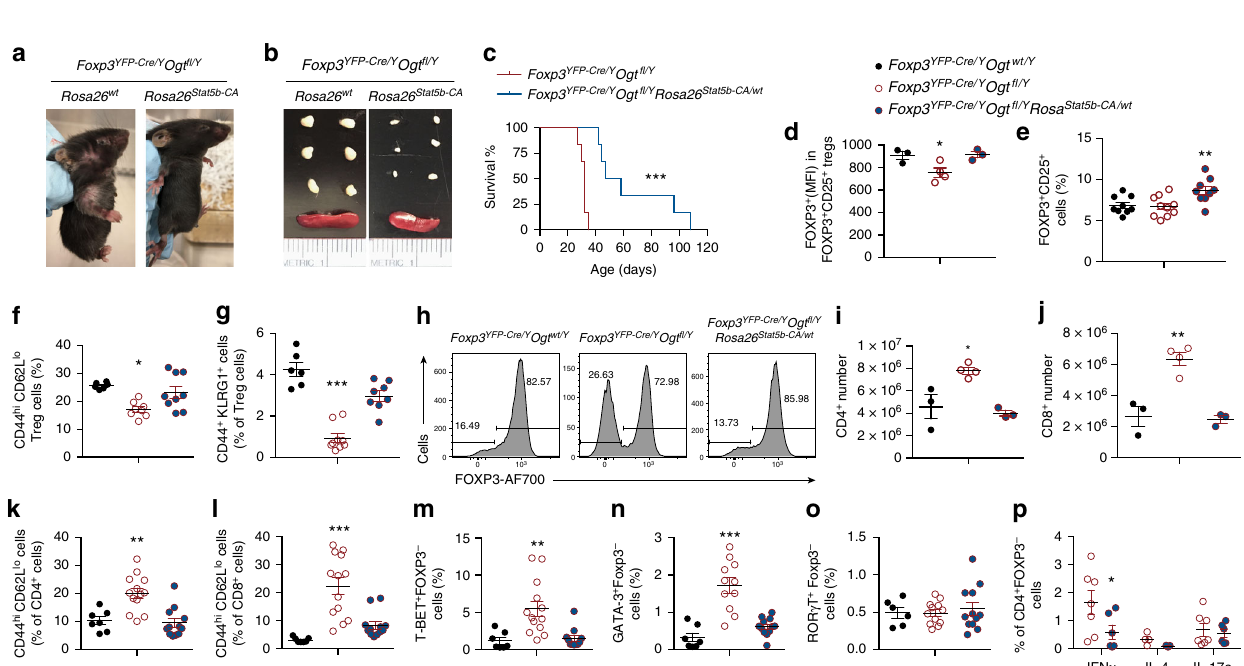
Fig. 7 Constitutive activation of STAT5 partially rescues Treg cell dysfunction. a , b Representative images of mice ( a ) and peripheral LNs and spleen ( b ) from 2-week-old Foxp3 YFP-Cre/Y Ogt fl /Y and Foxp3 YFP-Cre/Y Ogt fl /Y Rosa26 Stat5b-CA/wt mice. c Survival curve of Foxp3 YFP-Cre/Y Ogt fl /Y and Foxp3 YFP-Cre/Y Ogt fl /Y Rosa26 Stat5b-CA/wt mice ( n = 6). d MFI of FOXP3 in FOXP3 + CD25 + Treg cells in the LNs from 2-week-old Foxp3 YFP-Cre/Y Ogt wt/Y , Foxp3 YFP-Cre/Y Ogt fl /Y and Foxp3 YFP-Cre/Y Ogt fl /Y Rosa26 Stat5b-CA/wt mice, at least n = 3 each group. e Frequencies of FOXP3 + CD25 + Treg cells among CD4 + T cells, at least n = 9 each group. f – g Frequencies of CD44 hi CD62L lo ( f ) and CD44 + KLRG1 + ( g ) eTreg cells among FOXP3 + CD25 + Treg cells in the LNs from 2-week-old Foxp3 YFP-Cre/Y Ogt wt/Y , Foxp3 YFP-Cre/Y Ogt fl /Y and Foxp3 YFP-Cre/Y Ogt fl /Y Rosa26 Stat5b-CA/wt mice, at least n = 6 each group. h Histogram of FOXP3 expression in CD4 + CD25 + YFP + Treg cells in the LNs from 2-week-old Foxp3 YFP-Cre/Y Ogt wt/Y , Foxp3 YFP-Cre/Y Ogt fl /Y and Foxp3 YFP-Cre/Y Ogt fl /Y Rosa26 Stat5b-CA/wt mice. i , j Absolute number of CD4 + ( i ) and CD8 + ( j ) T cells in the LNs, at least n = 3 each group. k , l Frequencies of CD44 hi CD62L lo effector T cells in CD4 + ( k ) and CD8 + cells ( l ), at least n = 7 each group. m – o Frequencies of T-BET + ( m ), GATA3 + ( n ) and ROR γ T + ( o ) populations among CD4 + FOXP3 − cells in the LNs, at least n = 6 each group. p Frequencies of INF γ , IL-4 and IL-17A-producing CD4 + FOXP3 − cells from Foxp3 YFP-Cre/Y Ogt fl /Y and Foxp3 YFP-Cre/Y Ogt fl /Y Rosa26 Stat5b-CA/wt mice, at least n = 3 each group. Data are shown as mean ± s.e.m. * p < 0.05; ** p < 0.01; *** p < 0.001 by Kaplan-Meier Analysis ( c ), unpaired student ’ s t -test ( p ) and one-way ANOVA ( d – g , i – o )